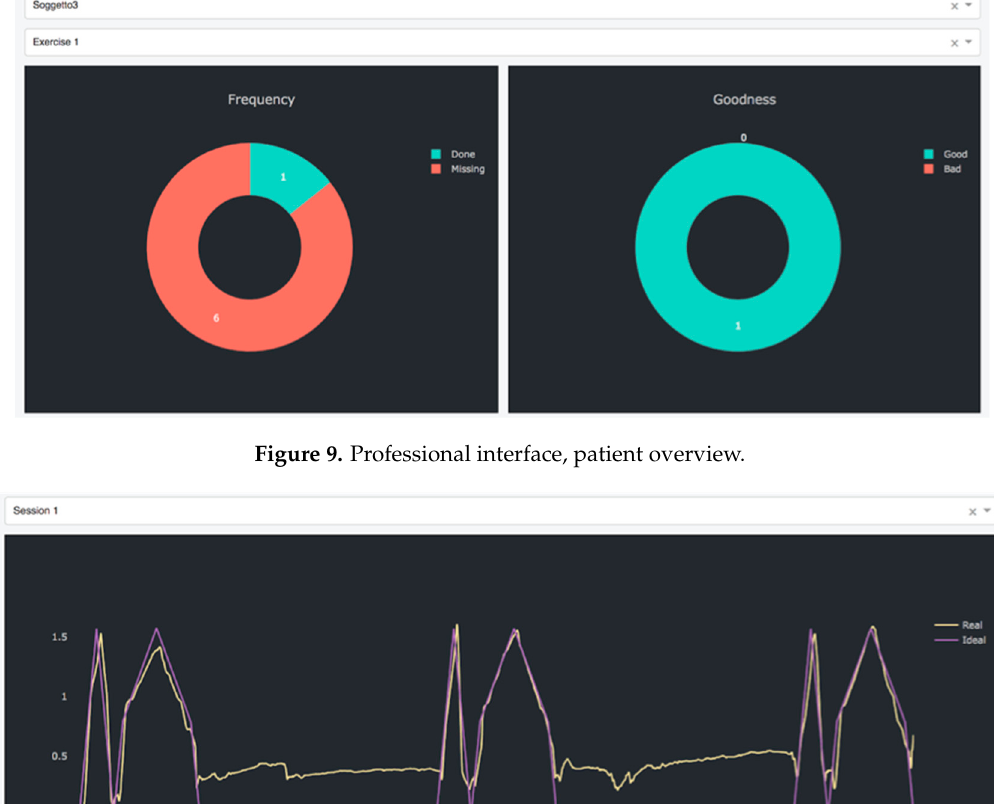
Figure 8. Android application layout.